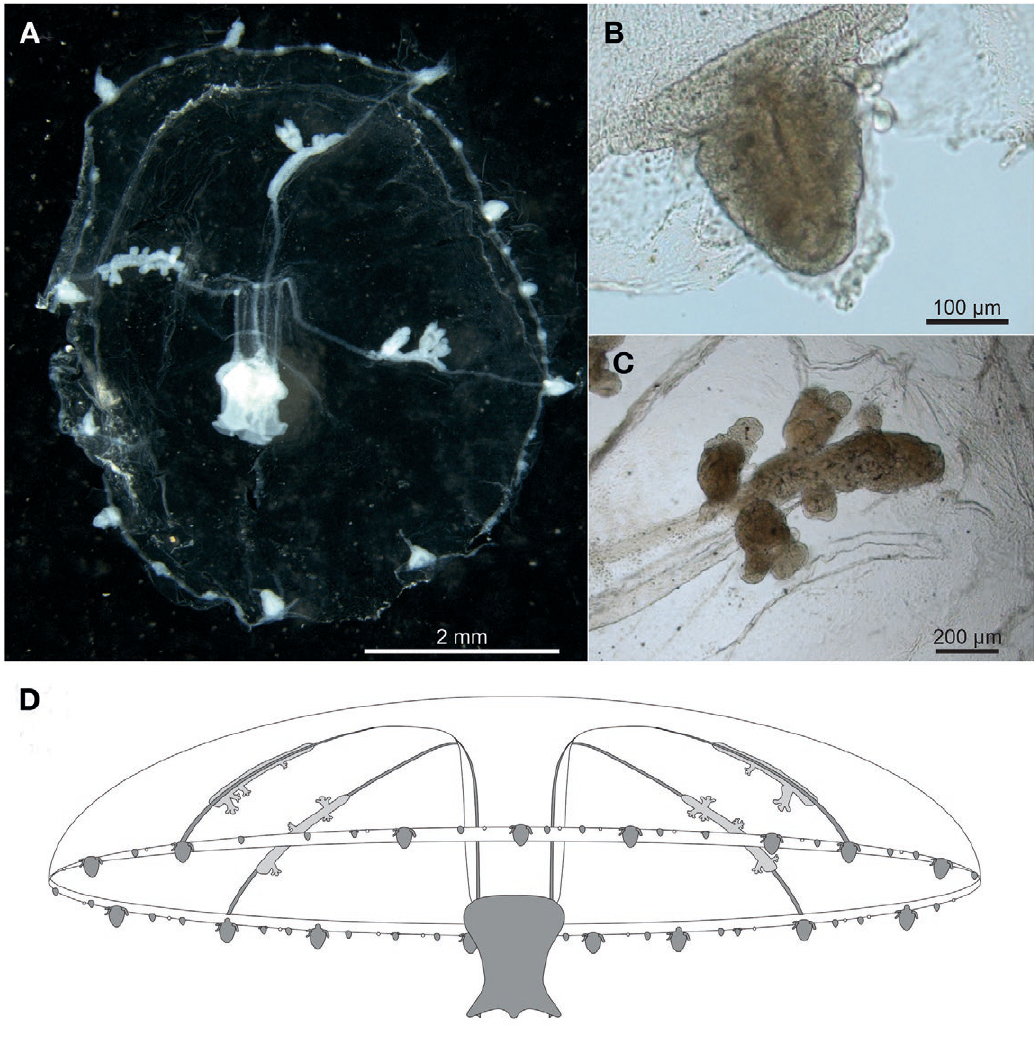
Fig. 4. – Helgicirrha angelicae n. sp. A, oral view of the holotype; B, detail of the tentacular bulb with lateral cirri; C, detail of a gonad with medusa buds; D, schematic representation of adult